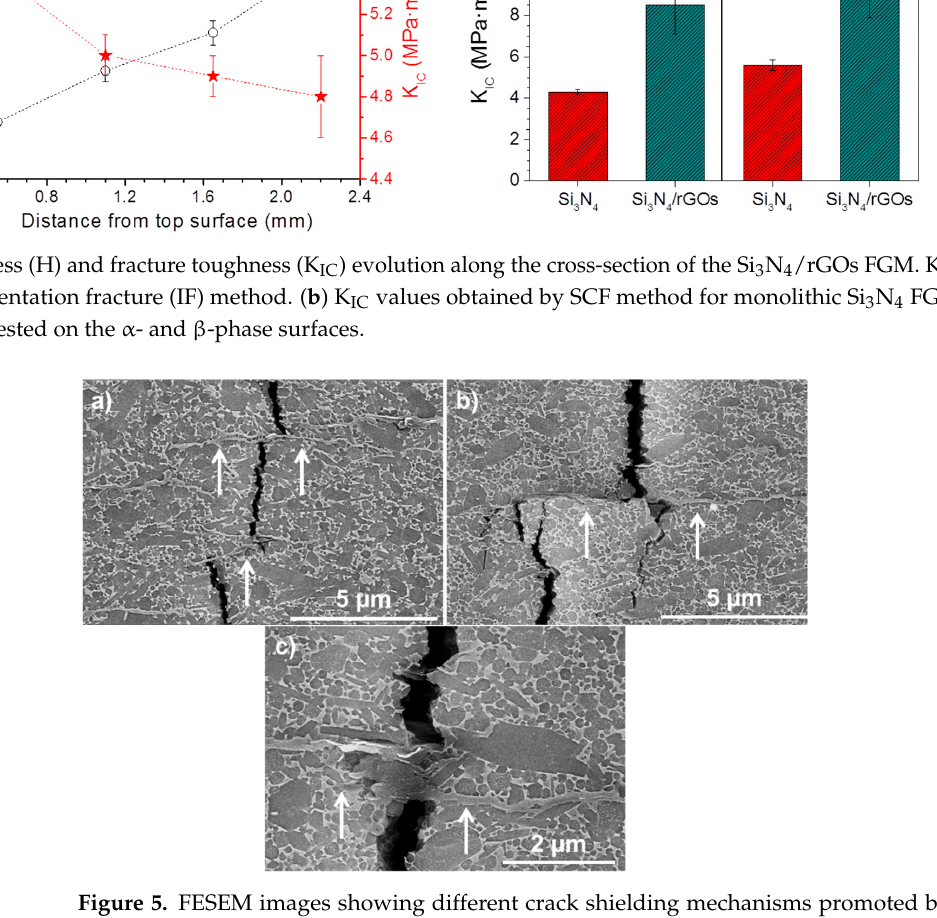
Figure 5. FESEM images showing different crack shielding mechanisms promoted by rGOs that would enhance the fracture toughness: ( a ) crack deflection, ( b ) crack branching and ( c ) crack bridging. Arrows point the rGOs location. The crack was generated by Vickers indentation performed on the polished cross-section of the FGM.